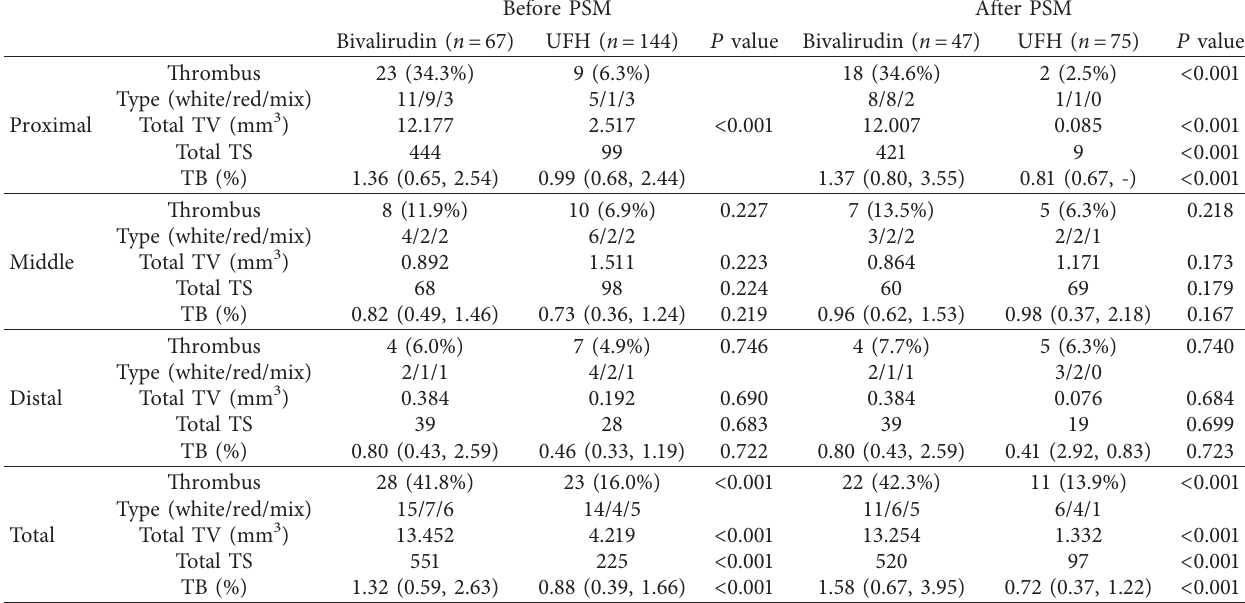
Table 2: Thrombus in the RA during coronary intervention.